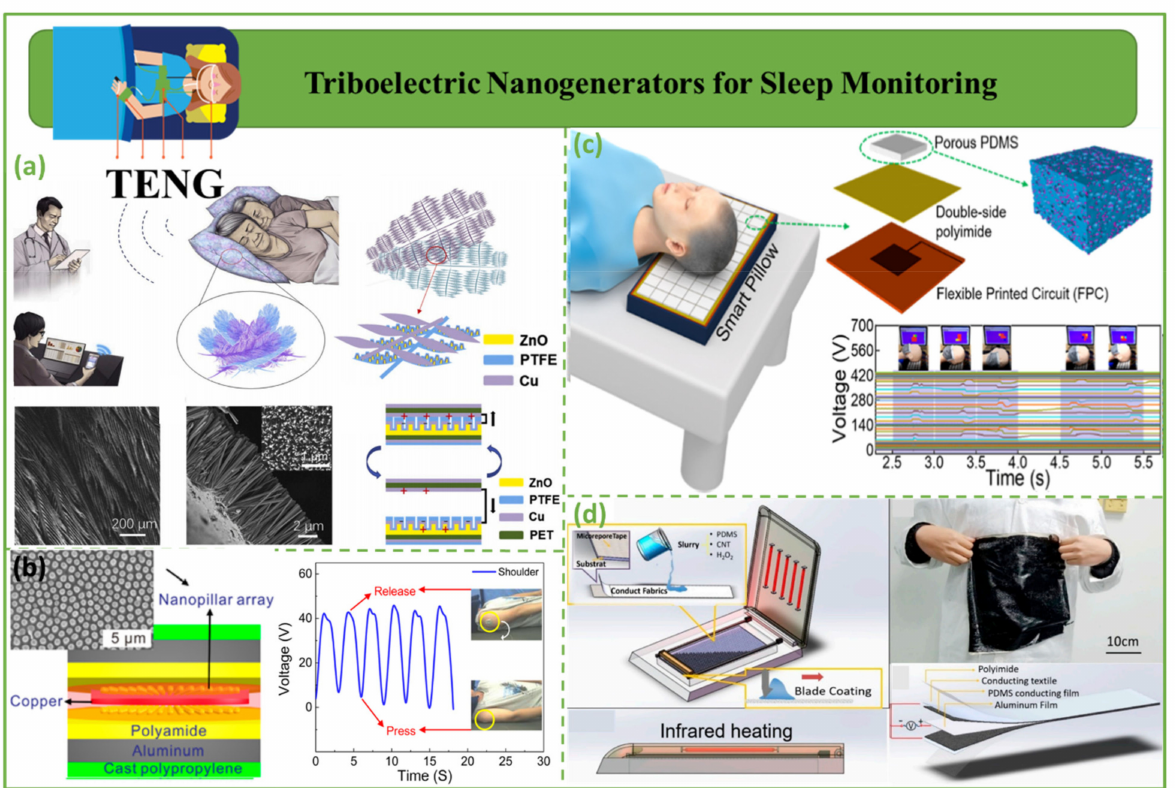
Figure 11. Triboelectric nanogenerators for sleep monitoring. ( a ) Structural design of a proposed smart pillow [127]. ( b ) The use of the TES to monitor the body during sleep [129]. ( c ) Utilization of an FB-TENG array in the form of a smart cushion for the purpose of monitoring head movement [130]. ( d ) Self-powered source for a bendable sensor for tracking human sleep